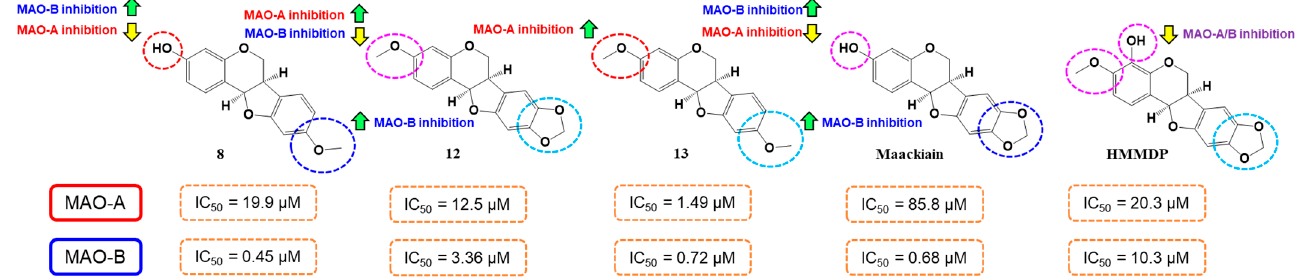
Figure 2. SAR analysis of pterocarpans for hMAO-A and hMAO-B inhibitions. Data of maackiain and HMMDP were from a reference [36]. HMMDP, 4-Hydroxy-3-methoxy-8,9-methylenedioxypter- ocarpan.